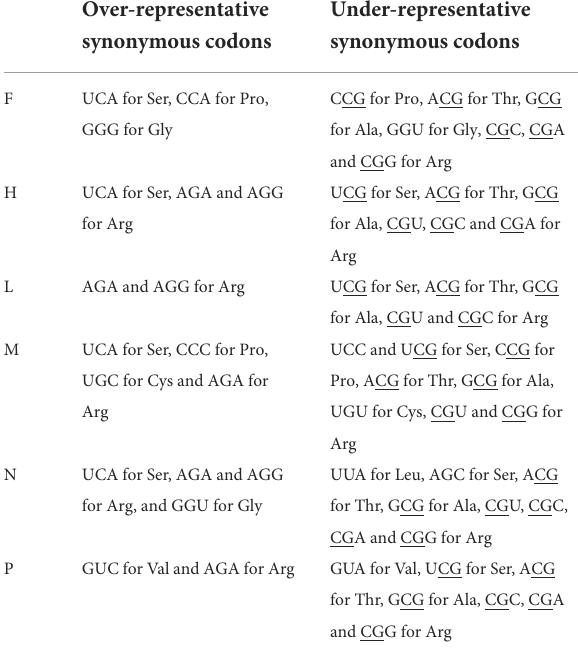
TABLE 1 The over-/under-representative synonymous codons in the six transcriptions of PPRV genome. Over-representative